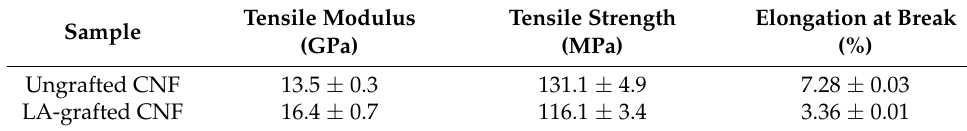
Table 2. Tensile properties of LA-grafted and ungrafted CNF